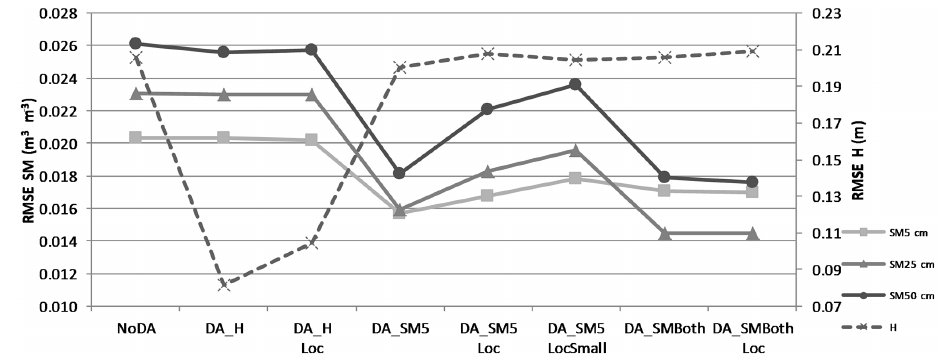
Figure 4. Spatially and temporally averaged RMSE of groundwater head and soil moisture at different depths for each univariate assimilation experiment in the Karup catchment. The left axis represents soil moisture and the right axis